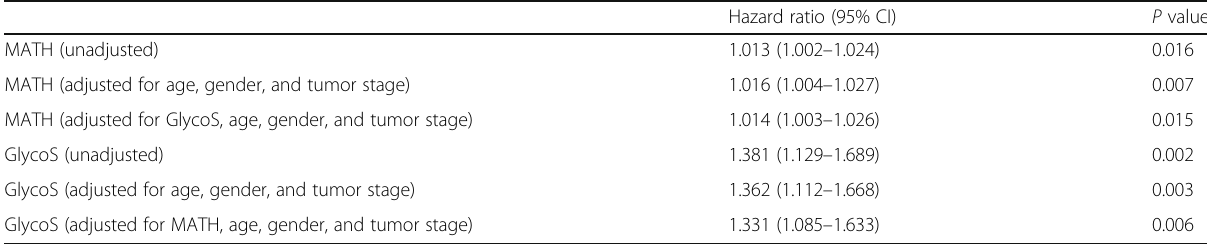
Table 2 Multivariate cox regression test for MATH and